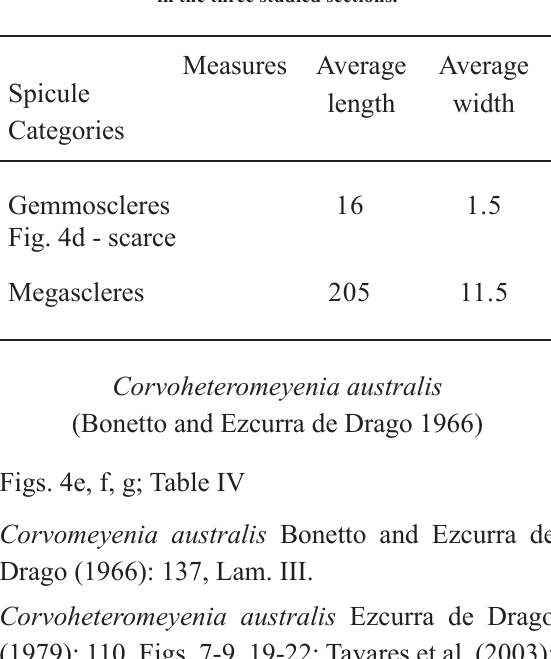
Category and measures (µm) of spicules of T. variabilis detected in the three studied sections.